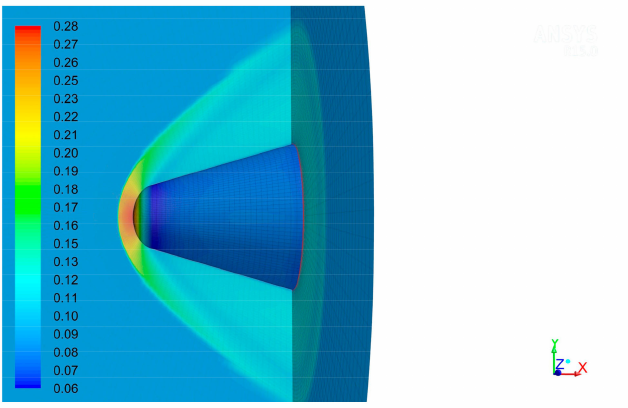
Figure 4. Density contours (kg/m 3 ) of the flow field at 20 km altitude, 2 Mach